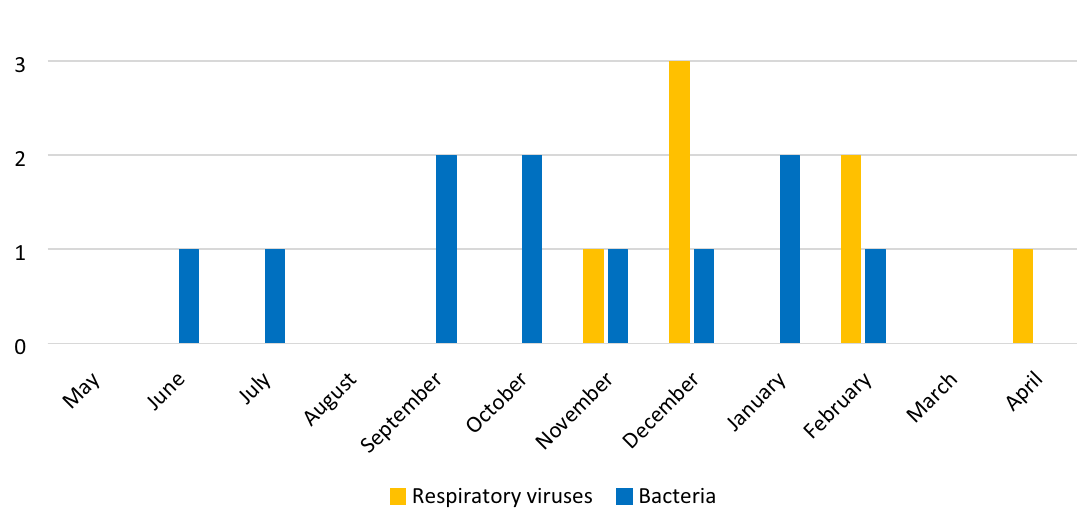
Figure 2. Monthly distribution of the microorganisms identified by conventional tests and mPCR.